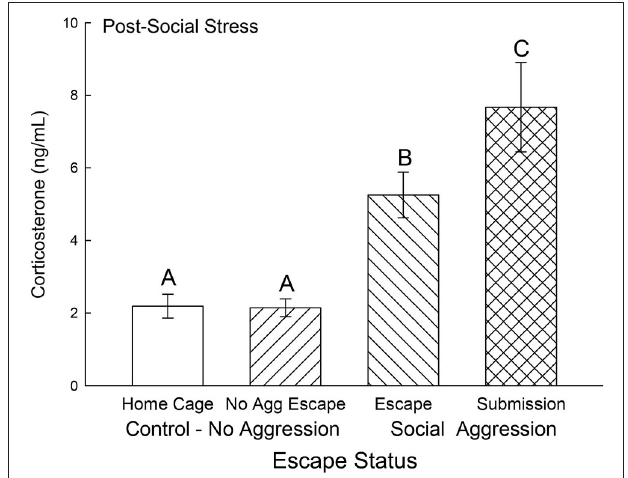
FIGURE 4 | Expectation of social aggression stimulates rapidly increased secretion of corticosterone . Mean ( ± SEM) plasma corticosterone on test day (CS+, no US) for cage controls (clear bars; N = 12), after SAM exposure in mice not receiving aggression (bars with left hatch; N = 7), after SAM plus social interaction in mice that escaped aggression on days 1–4 (right hatch; N = 11), and submissive mice (cross hatch; N = 5). Letters above the bar (A, B, C) signify statistical significance ( p < 0.05), such that bars that do not share a common letter (e.g., Escape = B vs. Submission = C) are significantly different, and those that do share a letter (e.g., Home Cage = A vs. No Aggression Escape = A) are